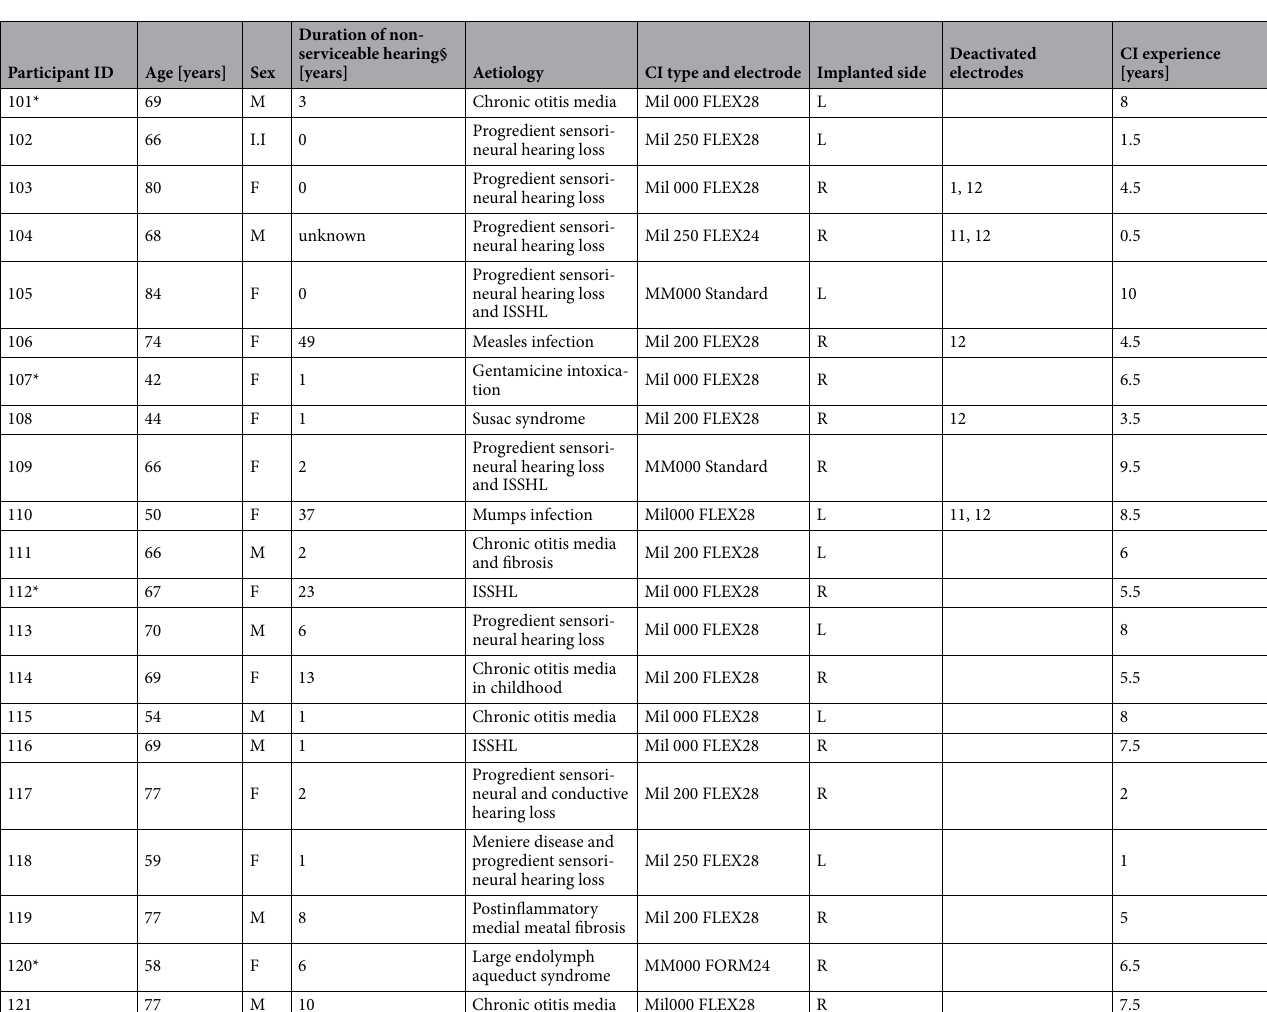
Table 2. Demographic data of the participants. L Left. R Right. F Female. M Male. ISSHL Idiopathic sudden sensorineural hearing loss. *Removed from analysis because of detachached recording electrodes or technical issues. §within the audiological indication for a CI. which usually means a word recognition score of 50% or less.